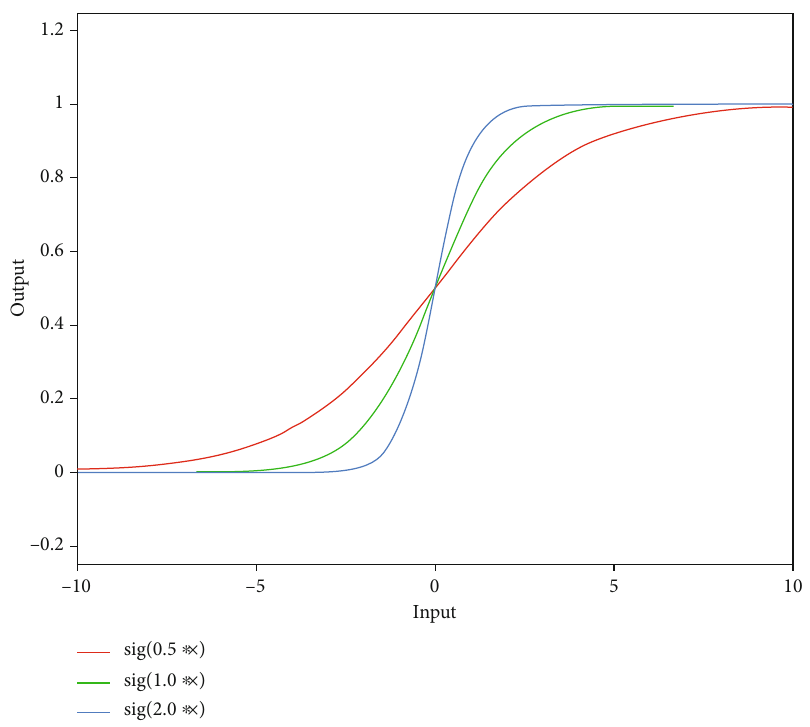
Figure 2: The sigmoid function result with various input weights without bias.